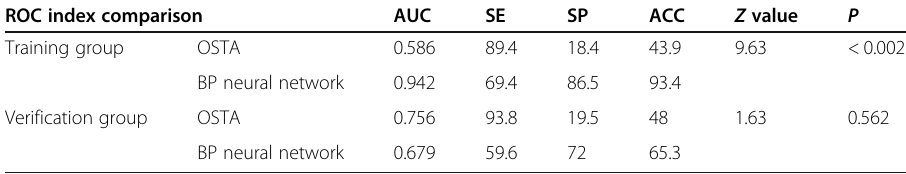
Table 4 ROC curve comparison between OSTA and BP neural network models ROC index